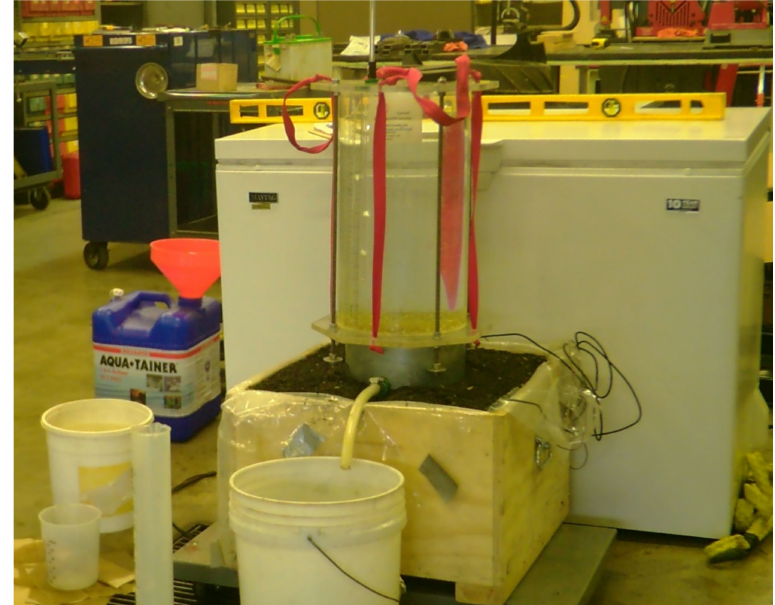
Figure 6. Laboratory experiment with the experimental